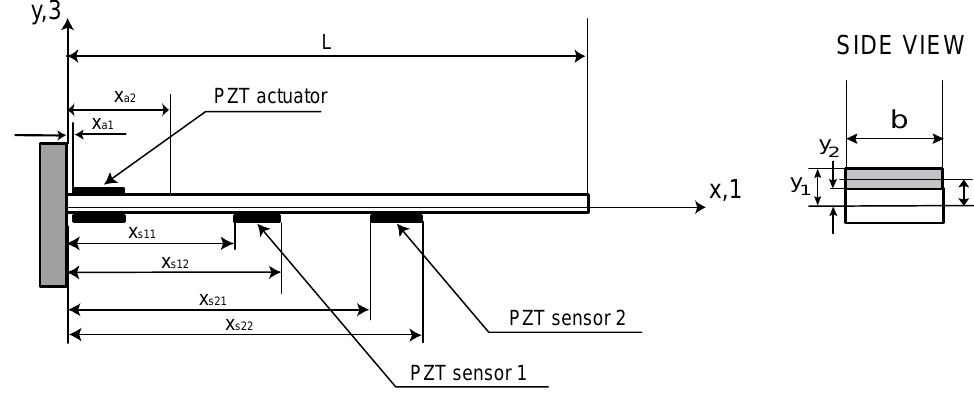
Fig. 4. Cantilever beam with PZT patches.